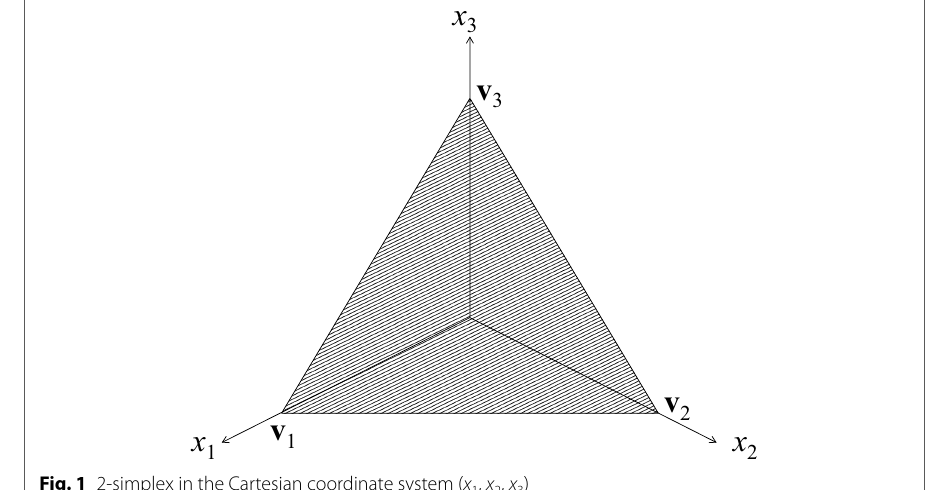
Fig. 1 2-simplex in the Cartesian coordinate system ( x 1 , x 2 , x 3 )